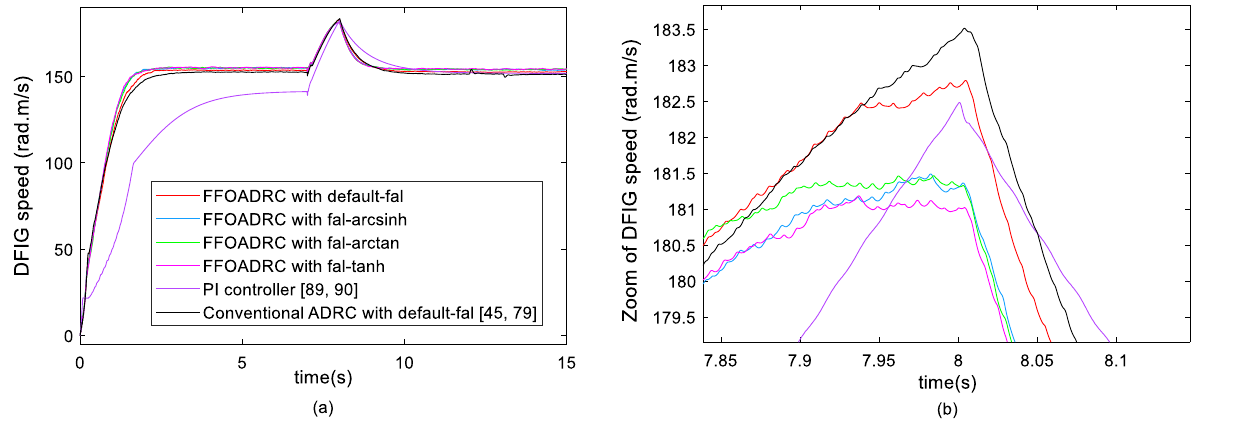
Fig. 18 The d and q components of the stator flux during symmetrical voltage sag for R crowbar ADRC with default-fal [45, 79], ( c ) FFOADRC with default-fal, ( d ) FFOADRC with fal-arcsinh, ( e ) FFOADRC with fal-arctan, and ( f ) FFOADRC with fal-tanh